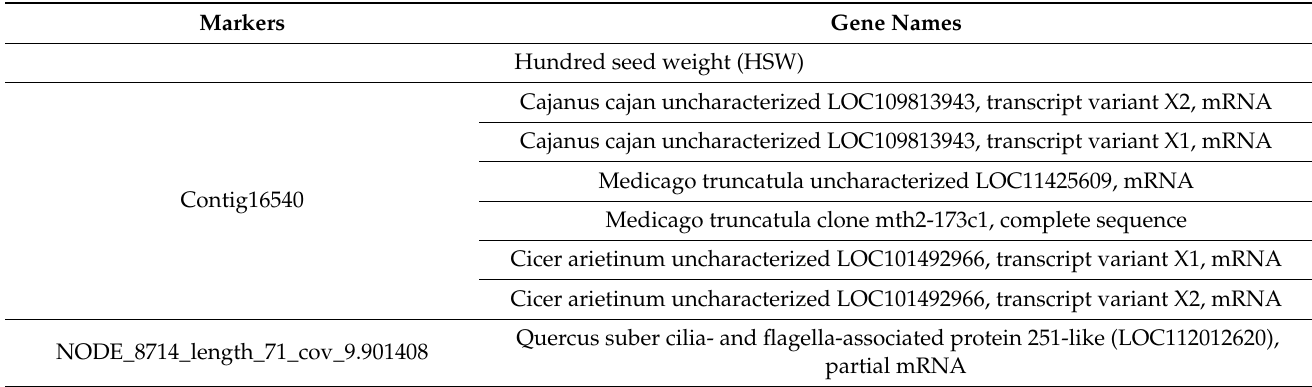
Table 8. Gene annotations of different identified SNPs markers associated with phenological and yield